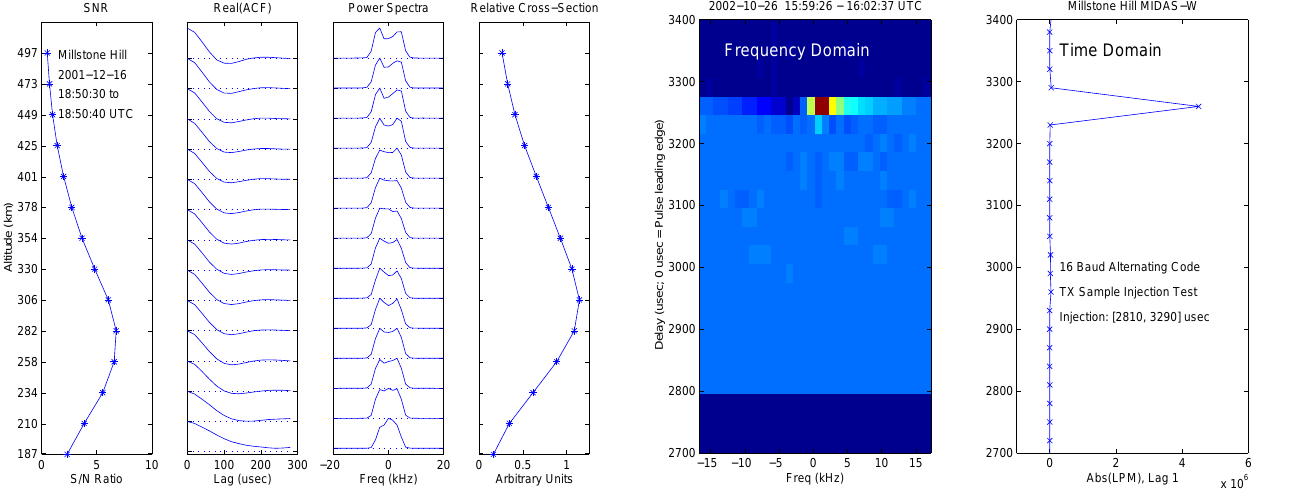
Fig. 9. Data from the outgoing transmitter digitization channel can be inserted into the receive samples at a known location to verify correct decoding of alternating code data. This figure shows the result of the processing, versus range (delay) and frequency in the left panel, and versus range (time) in the right